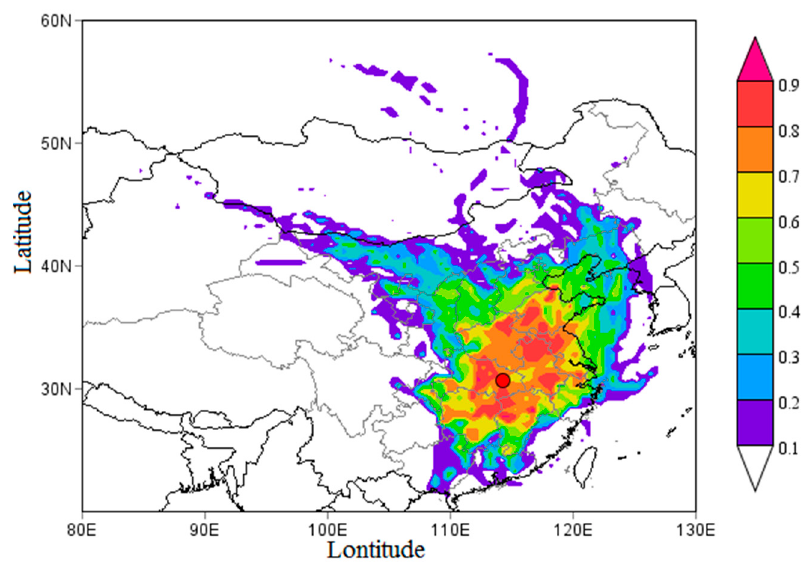
Figure 3. Spatial distribution of Weight Potential Source Contribution Function (WPSCF) for PM 2.5 in autumn-winter season in 2013–2016 in Wuhan (the orange point).